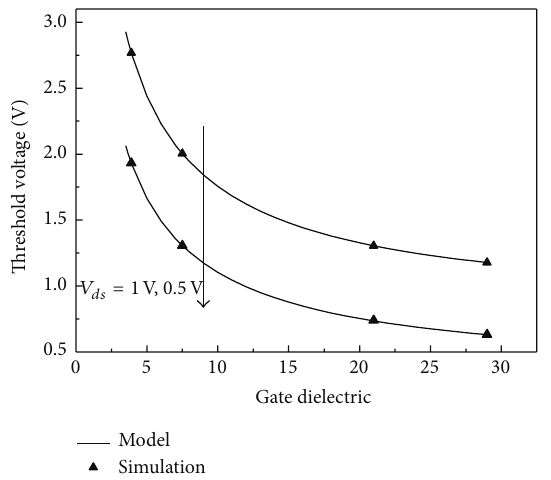
Figure10:Thresholdvoltageversusgatedielectricpermittivity. 𝑡 ox = = 10 nm, 𝐿 = 50 nm, and 𝑋 = 0.3 3 nm, 𝑡 SSi 𝑔